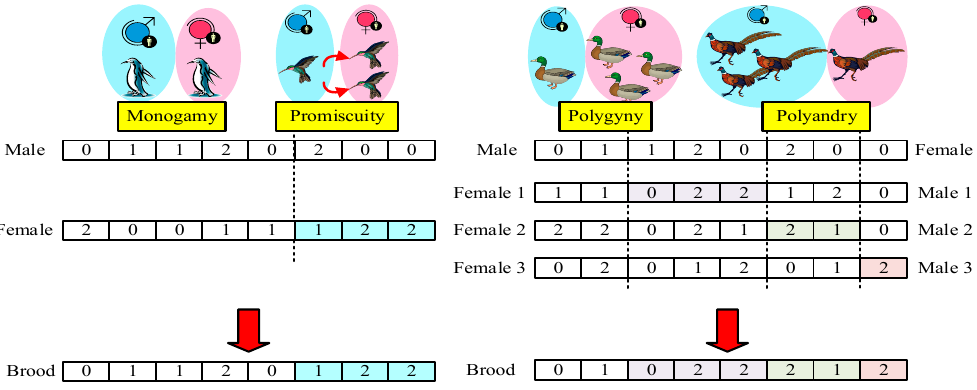
Figure 1. Mating process of all species of birds.